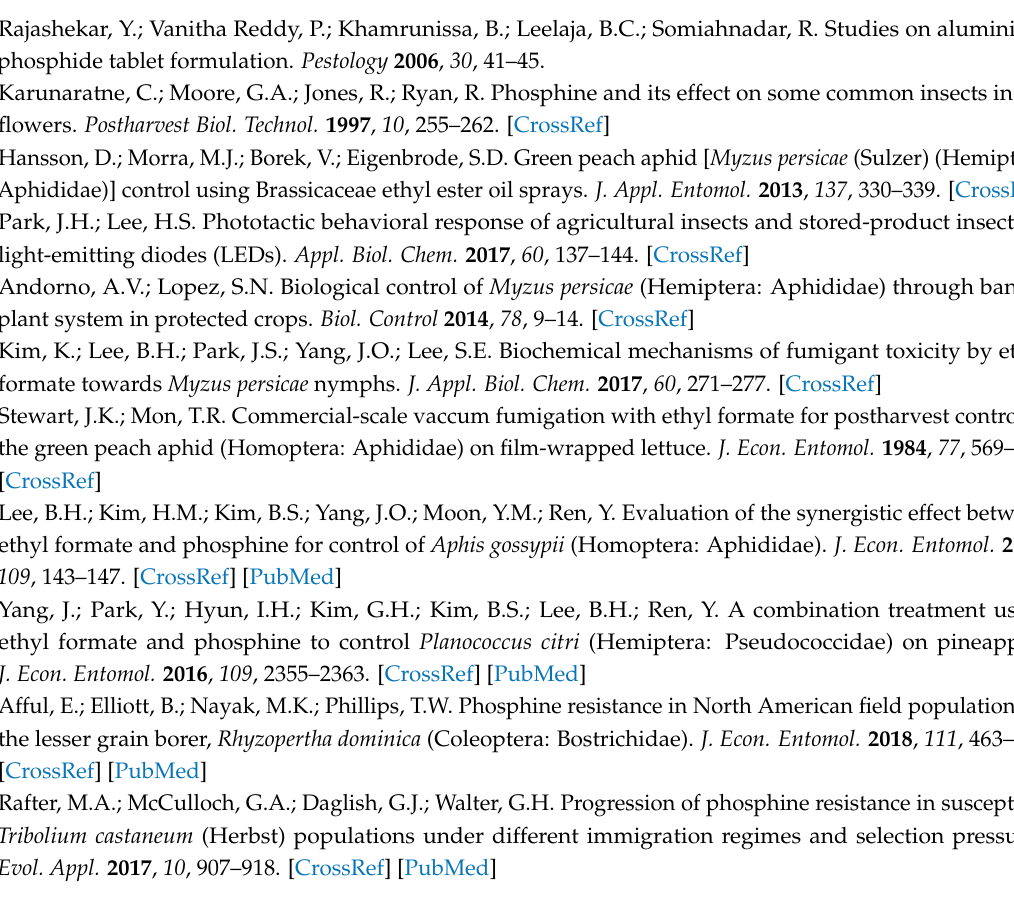
Figure S1. Mortality curve for the treatment of phosphine according to its concentration and fumigation duration towards Myzus persicae . (A), nymphs; (B), adults. Table S1. Primer list using RT-qPCR analysis. Table S2. Effects of phosphine fumigation on the different developmental stages of Myzus persicae . Table S3. Proteins differentially expressed in adults of Myzus persicae after phosphine treatment at the concentration of 0.5 mg/L for 4 h. CON; control treatment group, PH 3 ; phosphine treatment group. Proteomic analyses of Myzus persicae were undertaken using a Nano-LC-ESI-MS/MS technique. Statistical difference was analyzed using t -test ( p < 0.05). Proteins were involved in energy metabolism (especially, electron transport chain), defense, metabolism, and other proteins. Table S4. Proteins differentially expressed in adults of Myzus persicae after phosphine treatment at the concentration of 0.5 mg/L for 4 h. CON; control treatment group, PH3; phosphine treatment group. Proteomic analysis was conducted by a Nano-LC-MS/MS. Statistical difference was analyzed using t -test (p < 0.05). Proteins are classified in chromatin and histones, transcription, transition, and post-translational modification, signaling pathways and other functional roles in